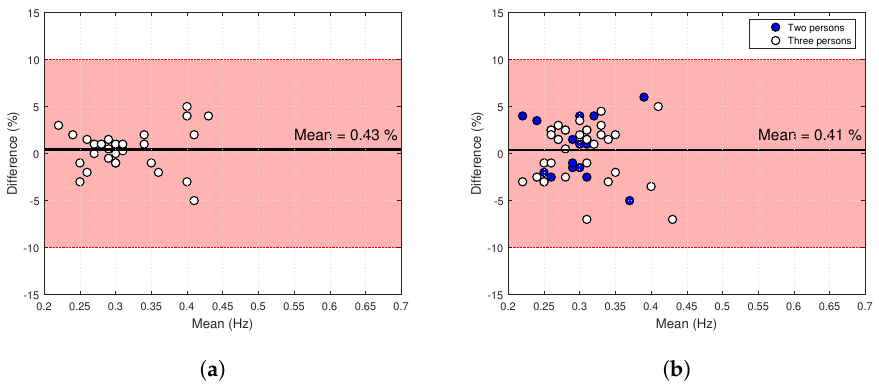
Figure 13. B&A plot analysis expressed as percentages of the values. Shaded areas present confidence interval limits for mean and agreement limits: ( a ) for one person, ( b ) for multiple persons.